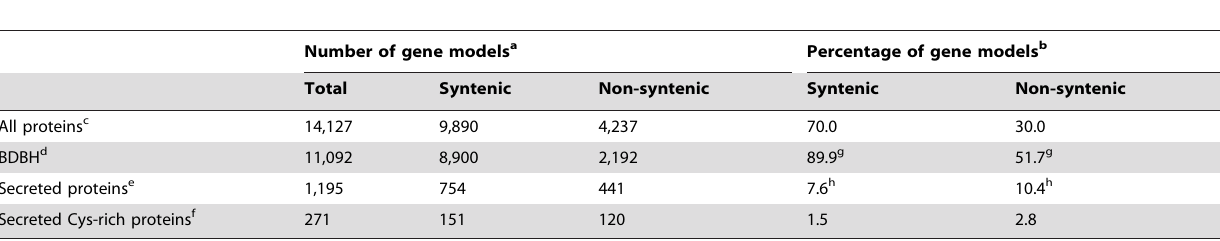
Table 5. Location of gene models of C. fulvum in regions syntenic or non-syntenic with the D. septosporum